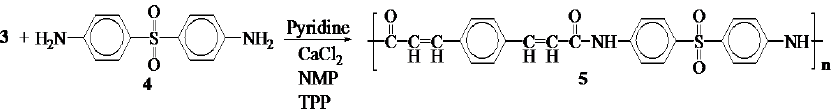
Figure 2. Scheme 2 of synthetic route of PA